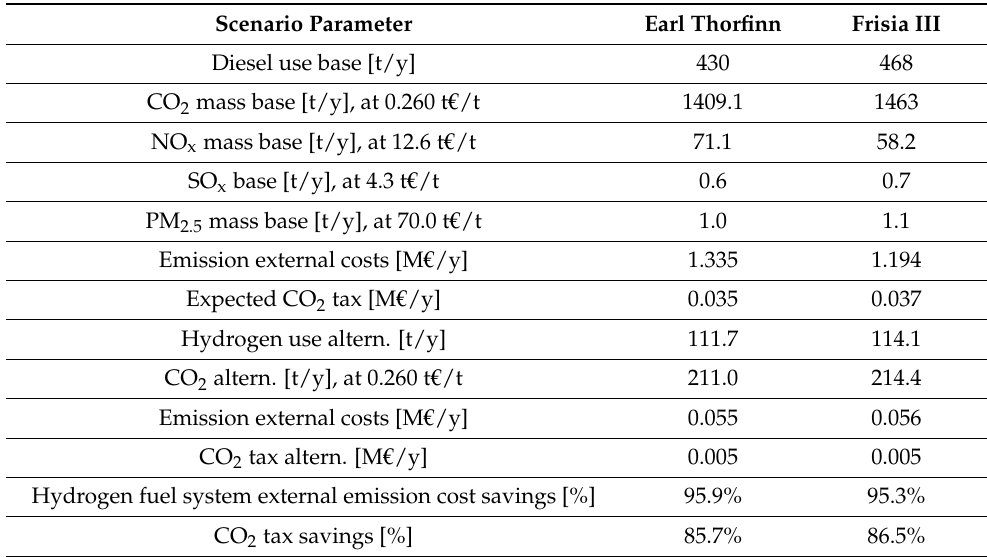
Table 6. Emission reductions through implementation of a hydrogen fuel